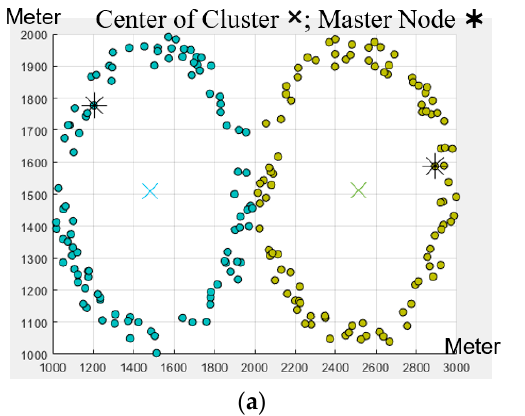
Figure 4. Single master election.